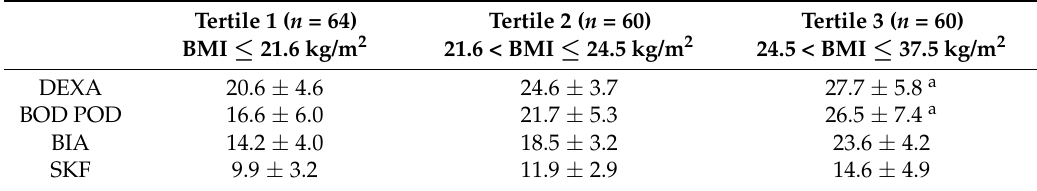
Table 2. Descriptive statistics of PBF separated by BMI tertiles for men.